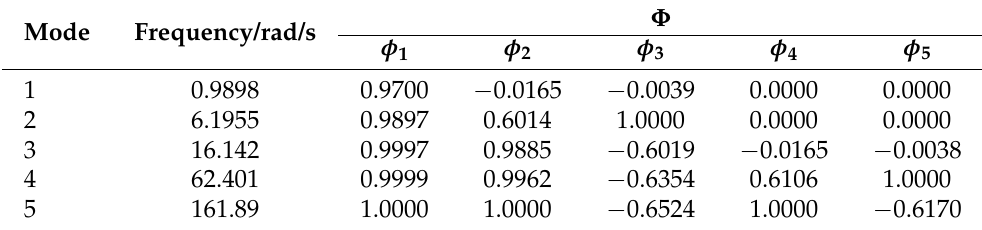
Table 11. Natural frequencies and modal shapes of the building (G2).